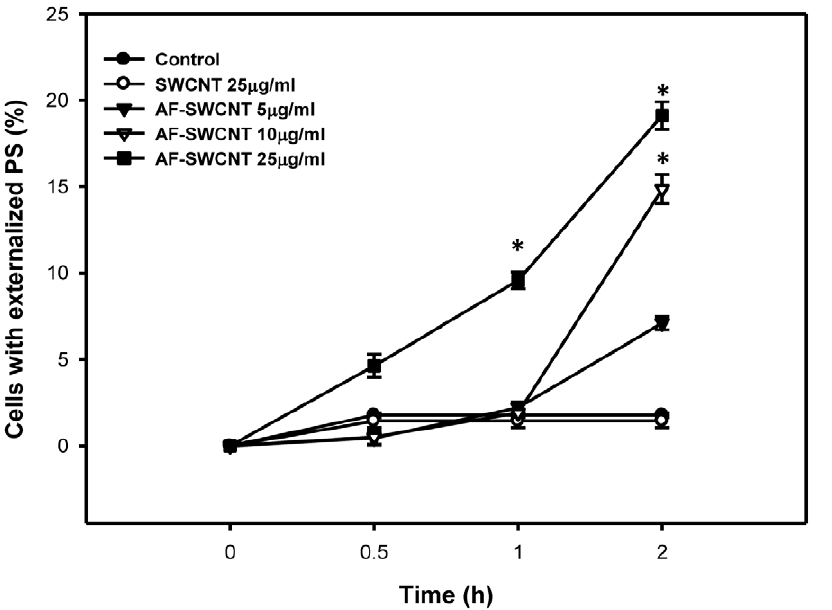
Figure 5. Effect of Control and acid functionalized SWCNTs on PS externalization in murine erythrocytes. Erythrocytes (0.5 6 10 6 in 100 m l RPMI + 1%FBS) from 6-8 weeks old C57BL/6 mice were incubated with given concentrations of control and acid functionalized SWCNTs for different time intervals at 37 u C. PS externalization was studied staining with annexin V-PE antibody. Percent annexin V positive erythrocytes (mean 6 SEM of three values) have been shown. *p , 0.05 as compared to control.